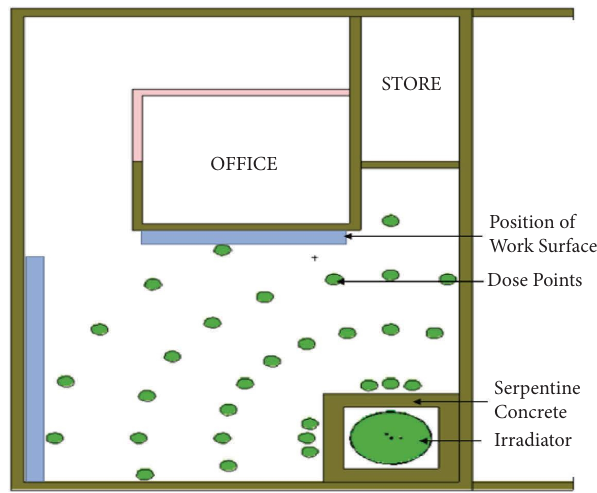
Figure 3: MCNP5 model of 241 Am-Be facility with serpentine concrete as